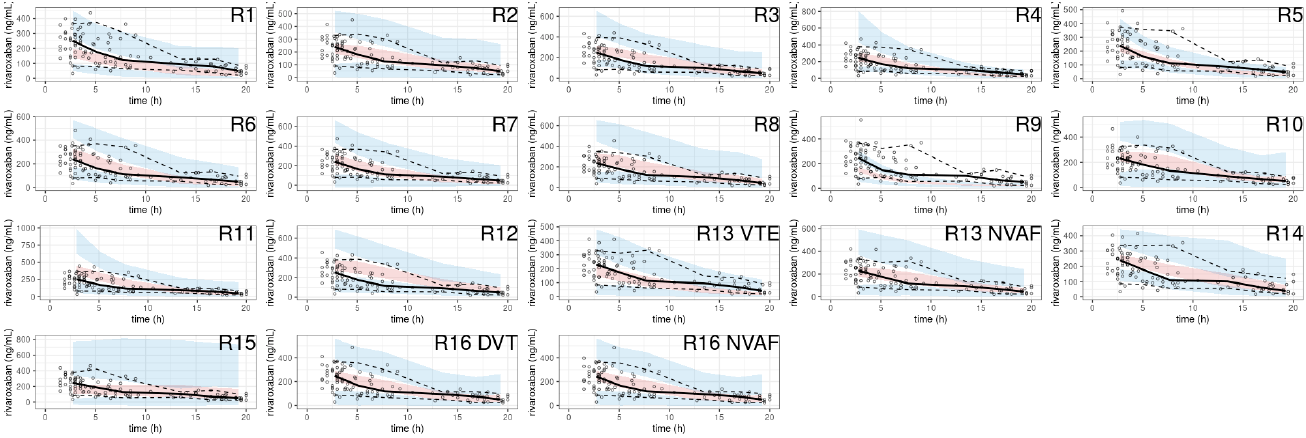
Figure 6. pcVPC of rivaroxaban population pharmacokinetic studies applied to the external validation dataset.